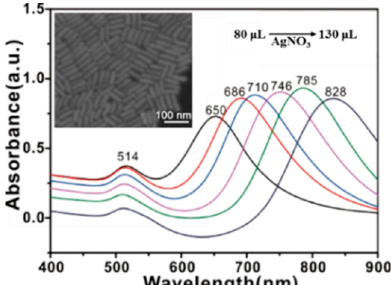
Figure 1. UV–visible spectra of GNRs solutions with addition of AgNO 3 (0.008 M) at 80, 90, 100, 110, 120 and 130 µL in growth solution. The inset shows a SEM image of GNRs with a longitudinal LSPR band at 785 nm.